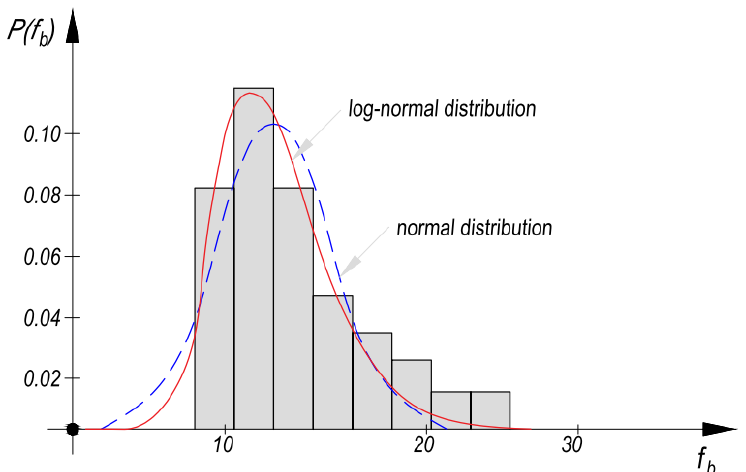
Figure 4. Sample histogram and matched density probability function of brick strength f b